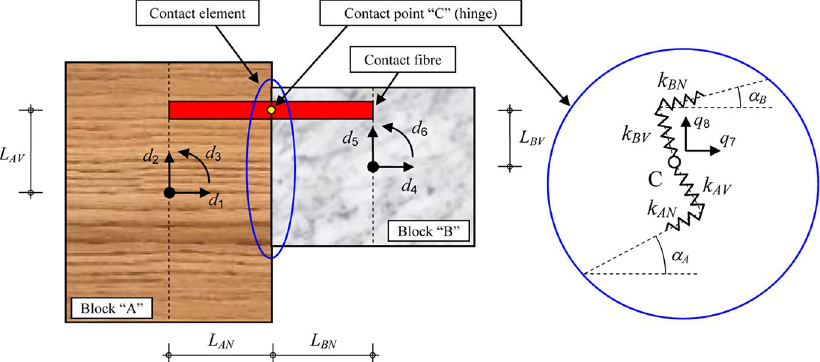
Fig. 1. Schematic representation of two neighbouring block elements and a fibre contact point as used in the